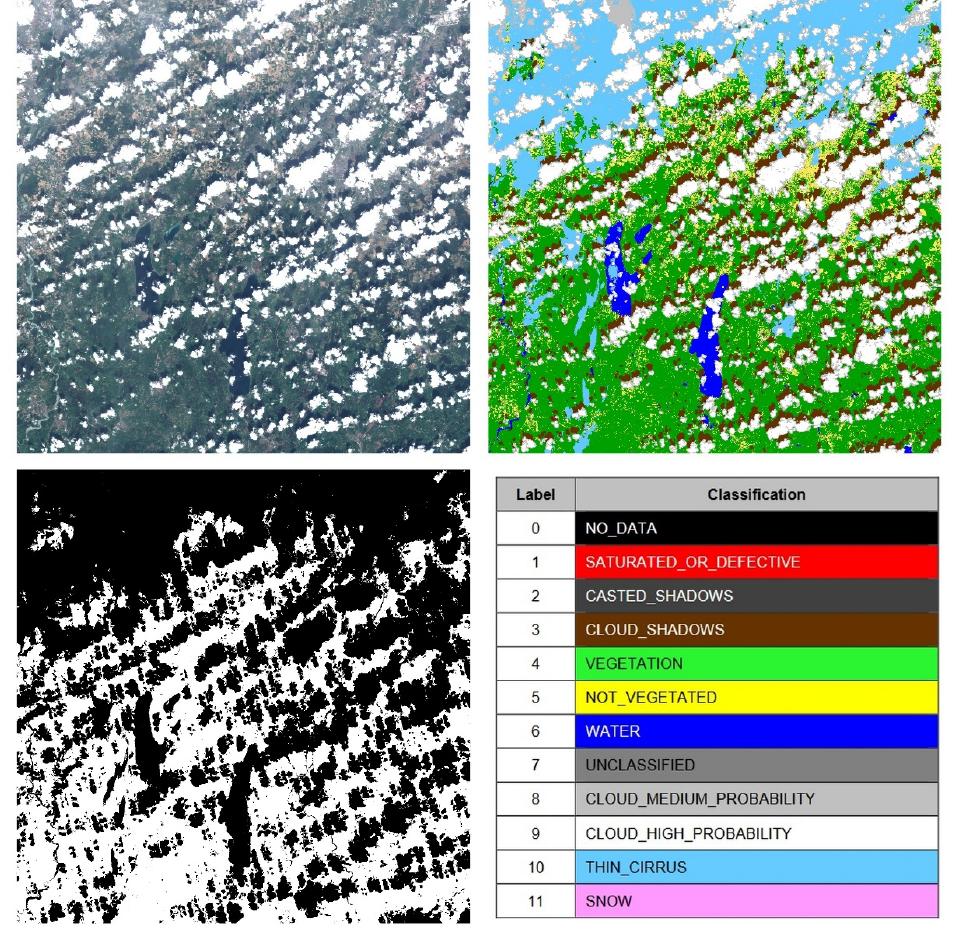
Figure 8. Top Left : L1C True Colour Image, Top Right : L2A SCL Map. Bottom Left : Sen2like Validity Mask, Bottom Right : L2A SCL Legend.